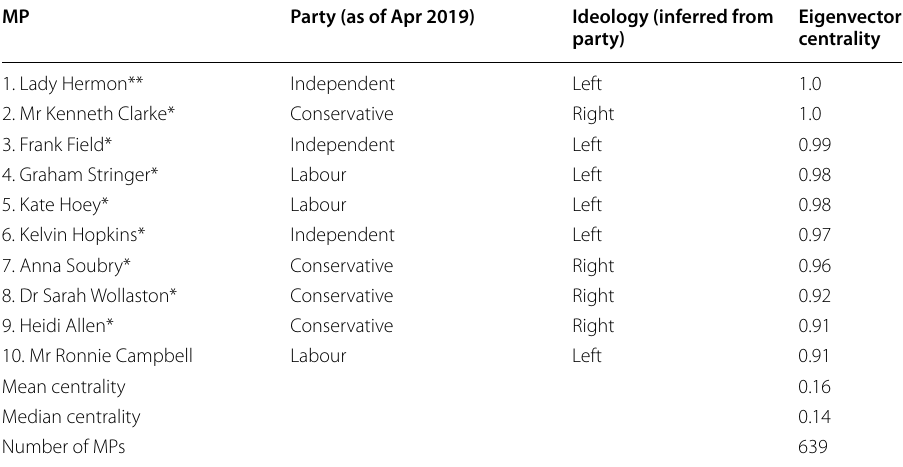
Lady Hermon (**) was not identified a rebel by visual inspection, but was labelled an Independent rebel in our “Data and Methods” section